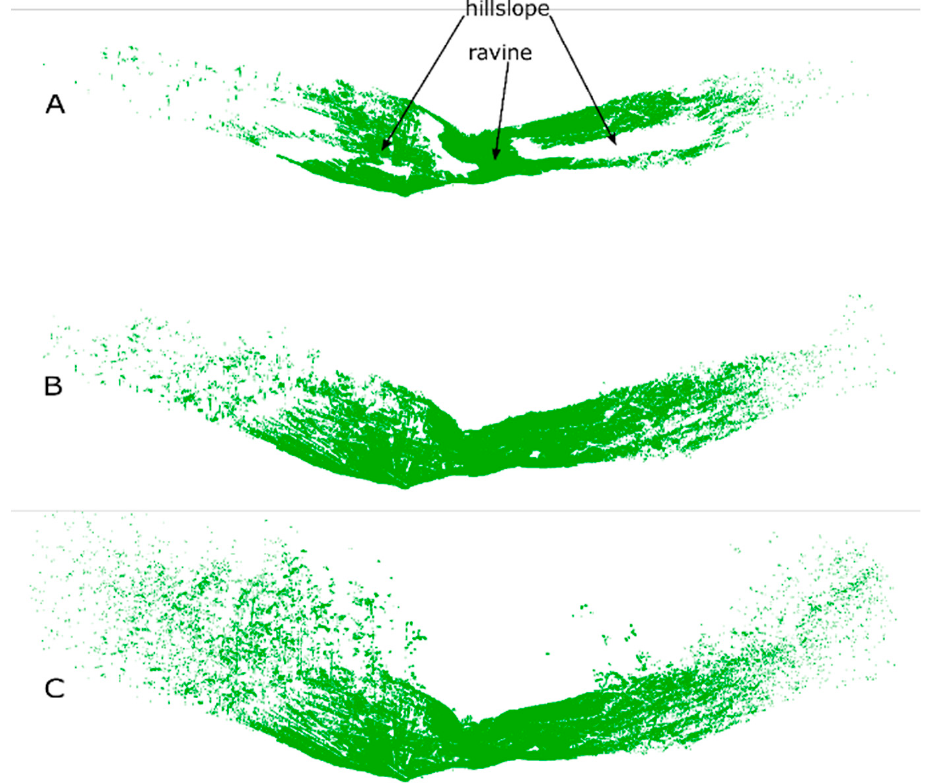
Figure 6. Ground points classified using the HWRI ( A ), CSF ( B ), and MSBF ( C ) classifiers for the vegetated site demonstrating the misclassification of points along steep slopes (as seen from above at an oblique angle).